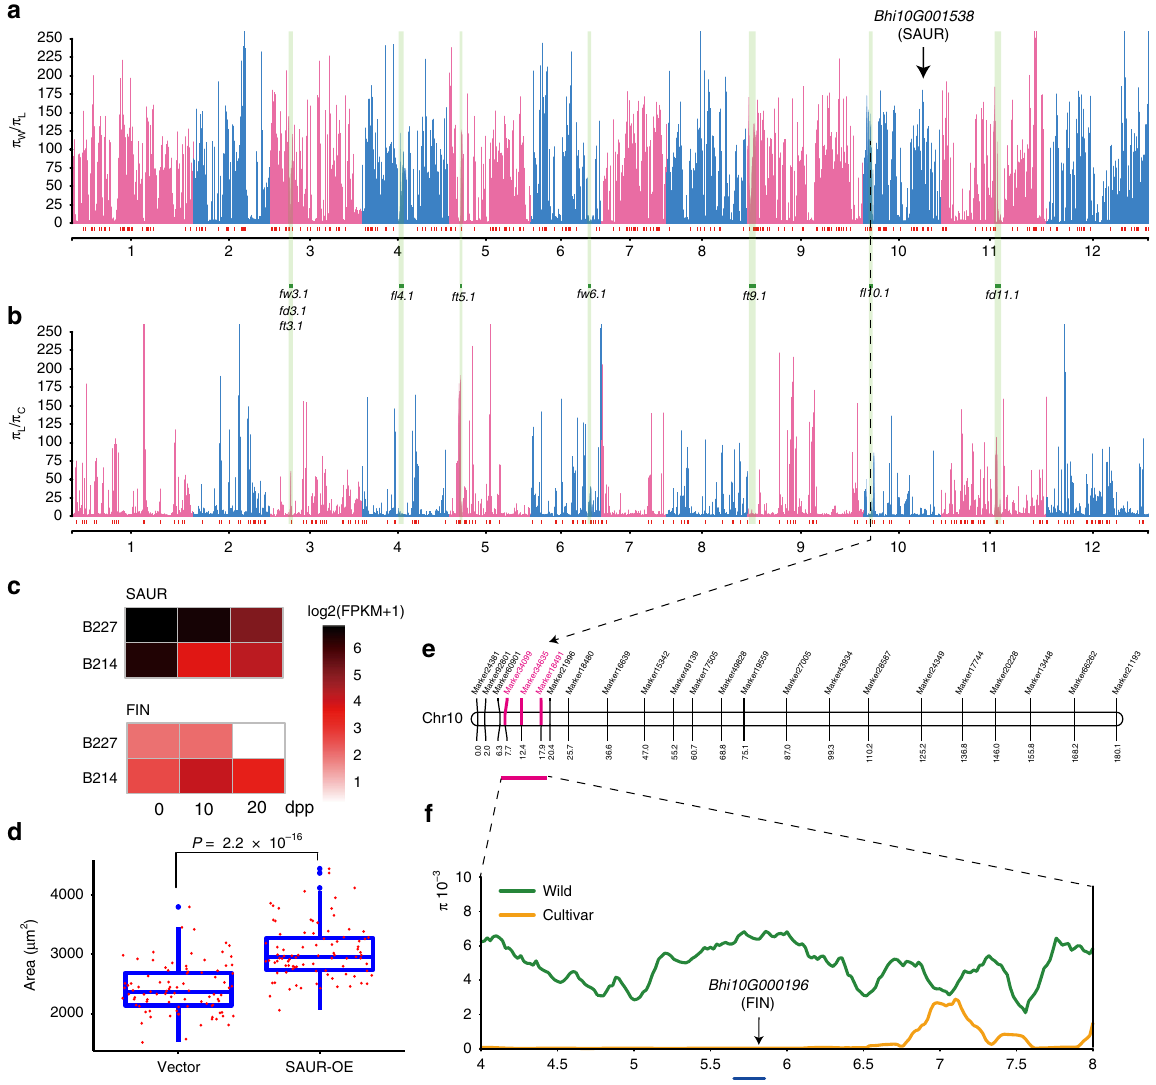
Fig. 5 Domestication/improvement selective sweeps and identi fi cation of fruit-size candidate genes in wax gourd. a , b Genome-wide distribution of selective sweeps during domestication and improvement. Red vertical boxes illustrate selective sweeps and light green bars illustrate QTLs related fruit size. c Differential expression of candidate genes related to fruit size between large (B227) and small (B214) fruited accessions, at three developmental stages. d Boxplots show the epidermal pavement cell size of wax gourd cotyledon with SAUR overexpression and empty vector (OE: overexpression), p value was calculated using one-sided Student ’ s t test. e A major fruit length QTL on chromosome 10. f Domestication sweeps within the genetically mapped QTL interval. Horizontal blue lines indicate sweep regions. The source data underlying a , b , and d are provided as a Source Data fi